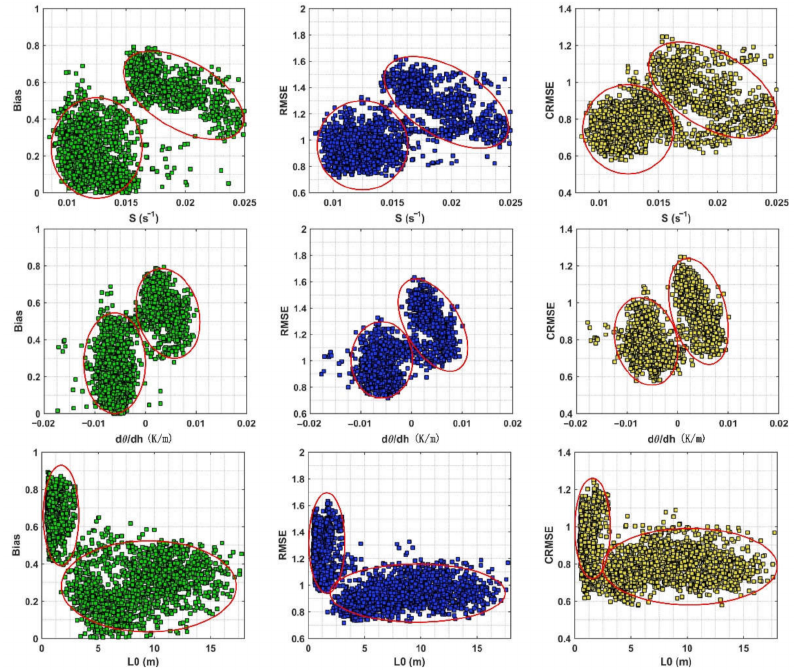
Figure 5. Statistical analysis of the relationship between statistical operators and turbulence